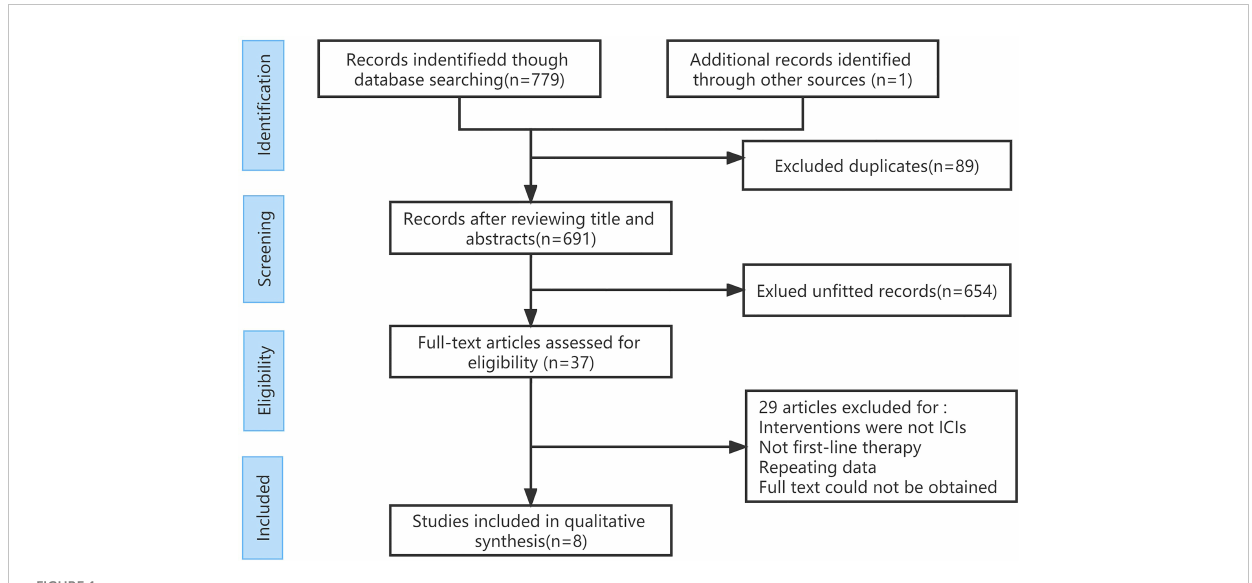
FIGURE 1 PRISMA Flowchart of the identi fi cation of eligible